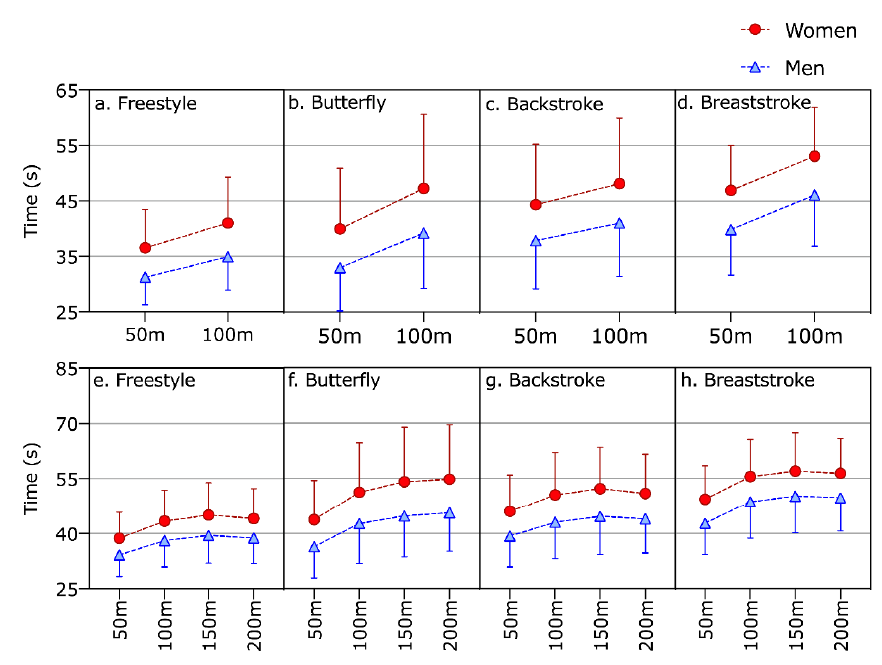
Figure 3. Race time for each 50 m split in 100 m ( a – d ) and 200 m ( e – h ) of men and women in the four strokes.